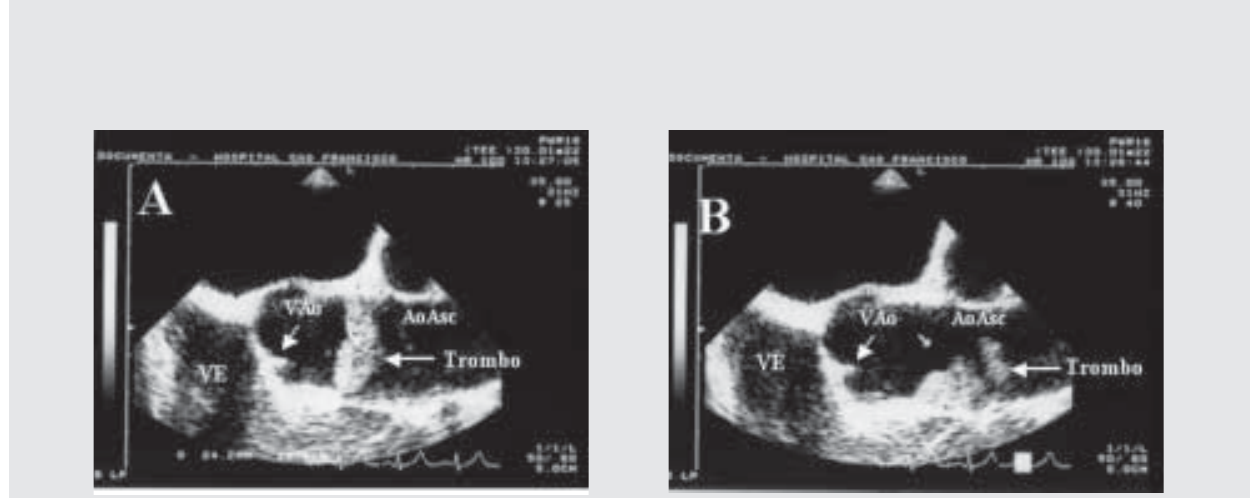
Fig. 1 - Long-axis echocardiograms showing pedunculated thrombus (arrow) in ascending aorta with aortic valve in closed position. (LV = left ventricle; AoV = aortic valve; AscAo = ascending